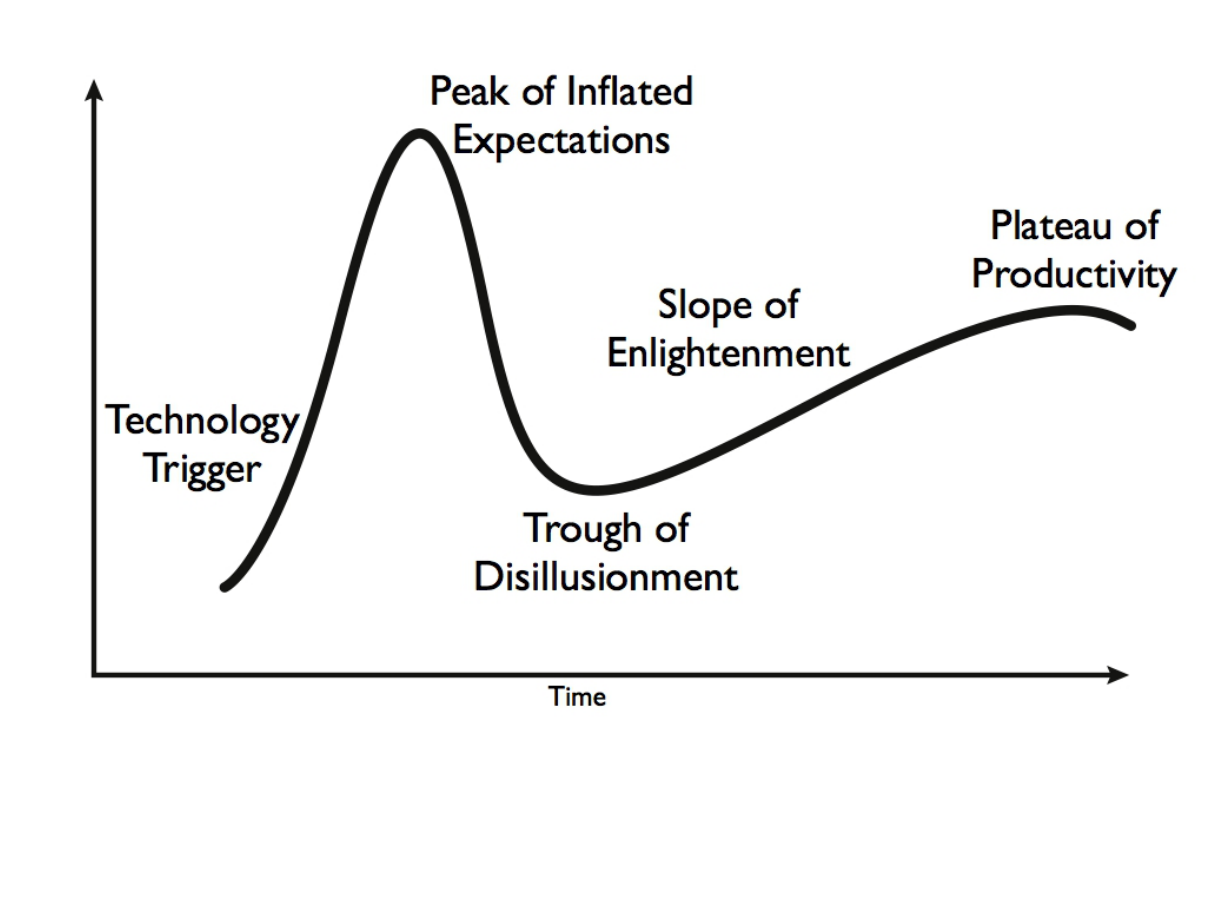
Figure 1. Gartner hype